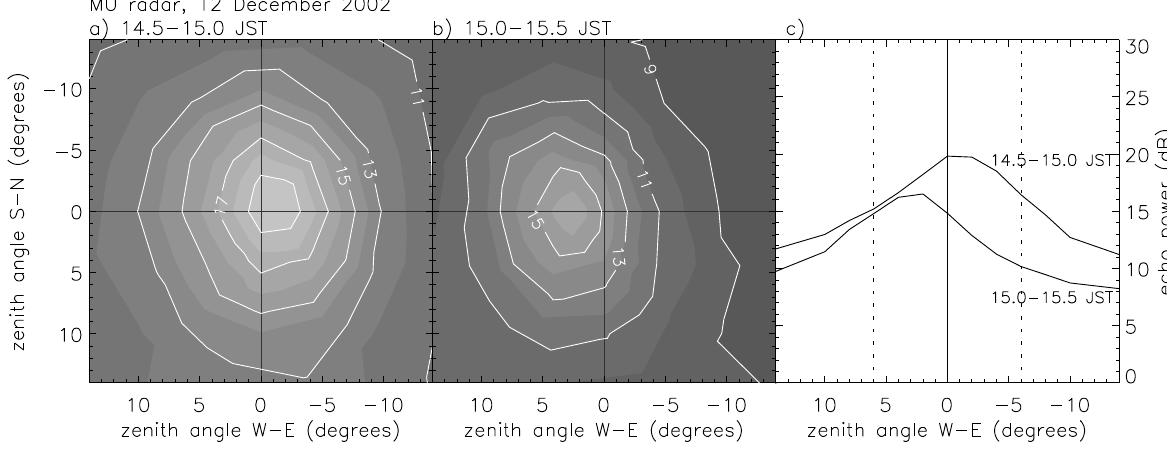
Fig. 6. ( a, b ) Pair of echo power maps, indB, their tilt from zenith moving several degrees east to west as mountain waves change phase in Figs. 2c and d; ( c ) cross-sections of (a, b), west-east through zenith, vertical dotted lines showing 6 ◦ zenith used in Figs. 2r and t. (a–c) are averaged 2–4km